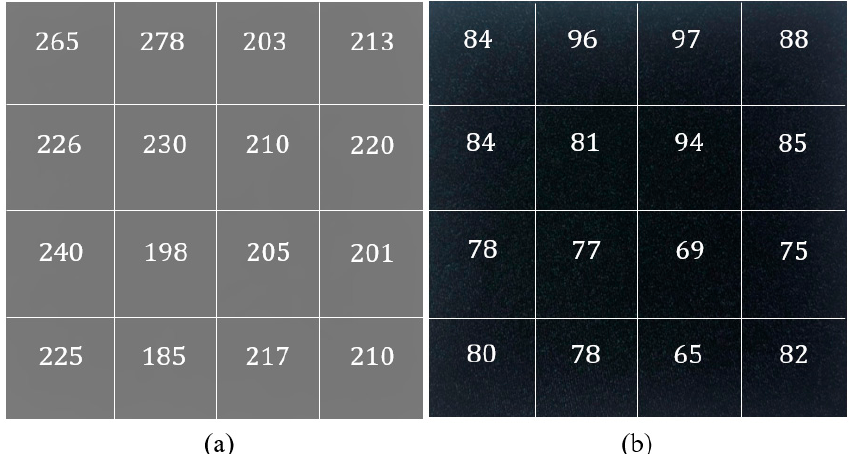
Figure 3. Representation of surface resistivity and the coating tone of the ( a ) nylon–Lycra and ( b ) PET fabric samples after being coated with PPy by using the reactant concentrations 0.05 M AQSA, 0.05 M pyrrole and 0.05 M iron(III) chloride.